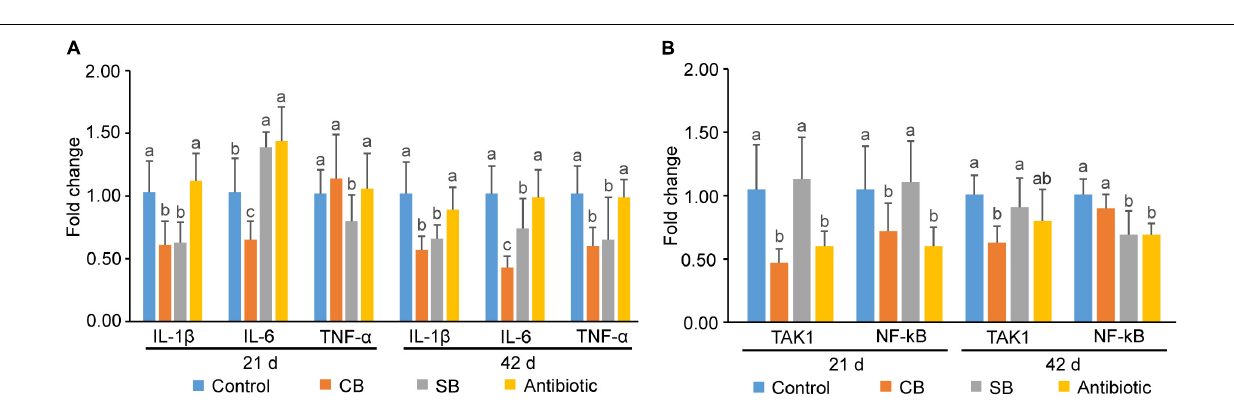
FIGURE 6 | Gene expression of inflammatory and immune-related genes in broiler jejunal mucosa. (A) Gene expression of inflammatory cytokines (IL-1 β , IL-6, and TNF- α ). (B) Gene expression of signaling pathway-related proteins (TAK1, NF-kB). Significant differences are shown by bars labeled with various